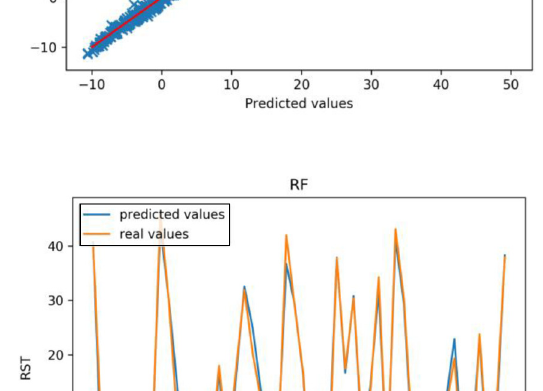
Figure 11. Regression plot for